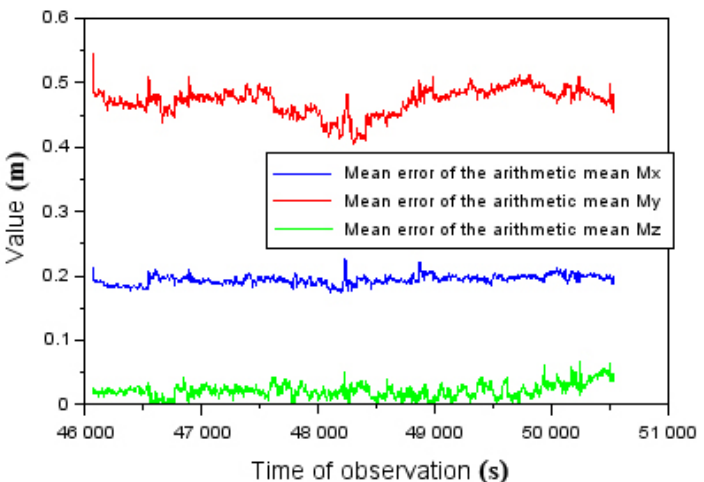
Figure 11. Mean errors of the arithmetic means ( M x , M y , M z ) from the adjustment scheme ( P g = 1 P r = 1 ns r